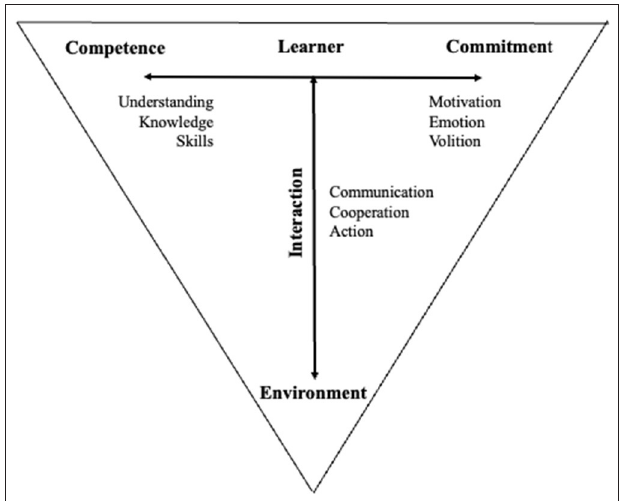
FIGURE 5 | An illustration of the three dimensions of learning [inspired by Illeris (2009) ].